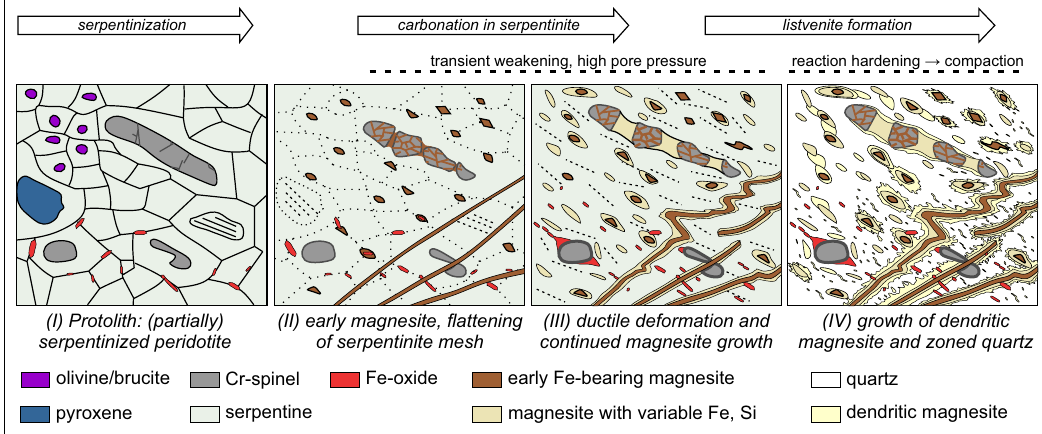
Fig. 8 Schematic mineral growth and deformation evolution during progressive reaction of serpentinite to listvenite in sheared intervals of Hole BT1B. While the sketch illustrates the temporal evolution from reaction stages I – IV, these likely occurred simultaneously across an advancing reaction front, with strain partitioned into the weak, serpentine-bearing and fl uid saturated reacting assemblages (Stages II and III). Talc and opal, which may have formed locally during stages II/III and IV, respectively, are omitted in the